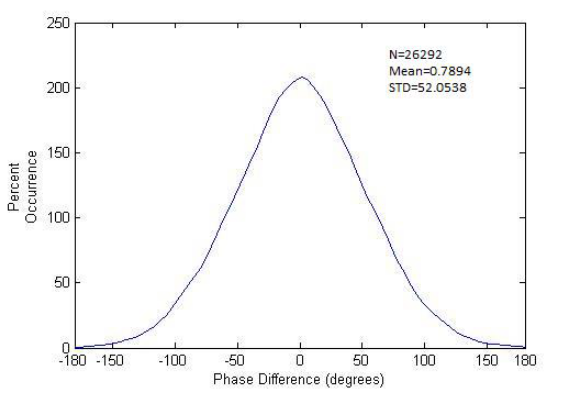
Figure 2. PPD distribution for the near-range of FQ18 Fig. 3 and Fig. 4 shows PPD distributions for two